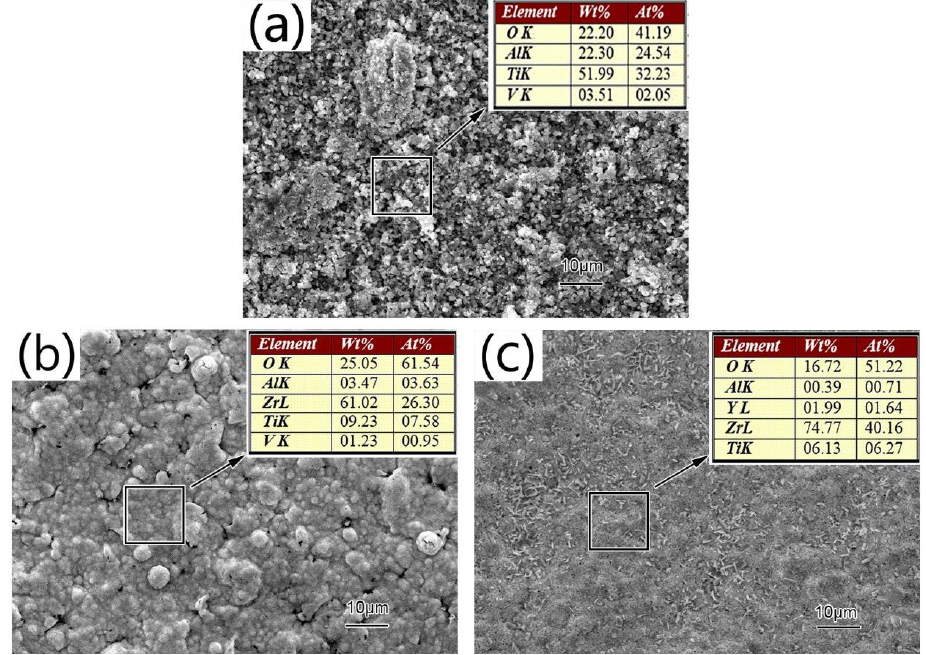
Figure 11. XRD pattern of the specimens at 850 °C for 100 h: ( a ) Zr coating; ( b ) Zr-Y coating.